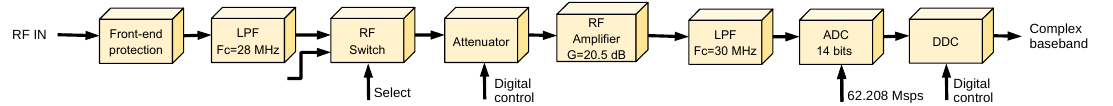
Figure 7. Block Diagram of WHISPER RF Front-end Direct Sampling HF